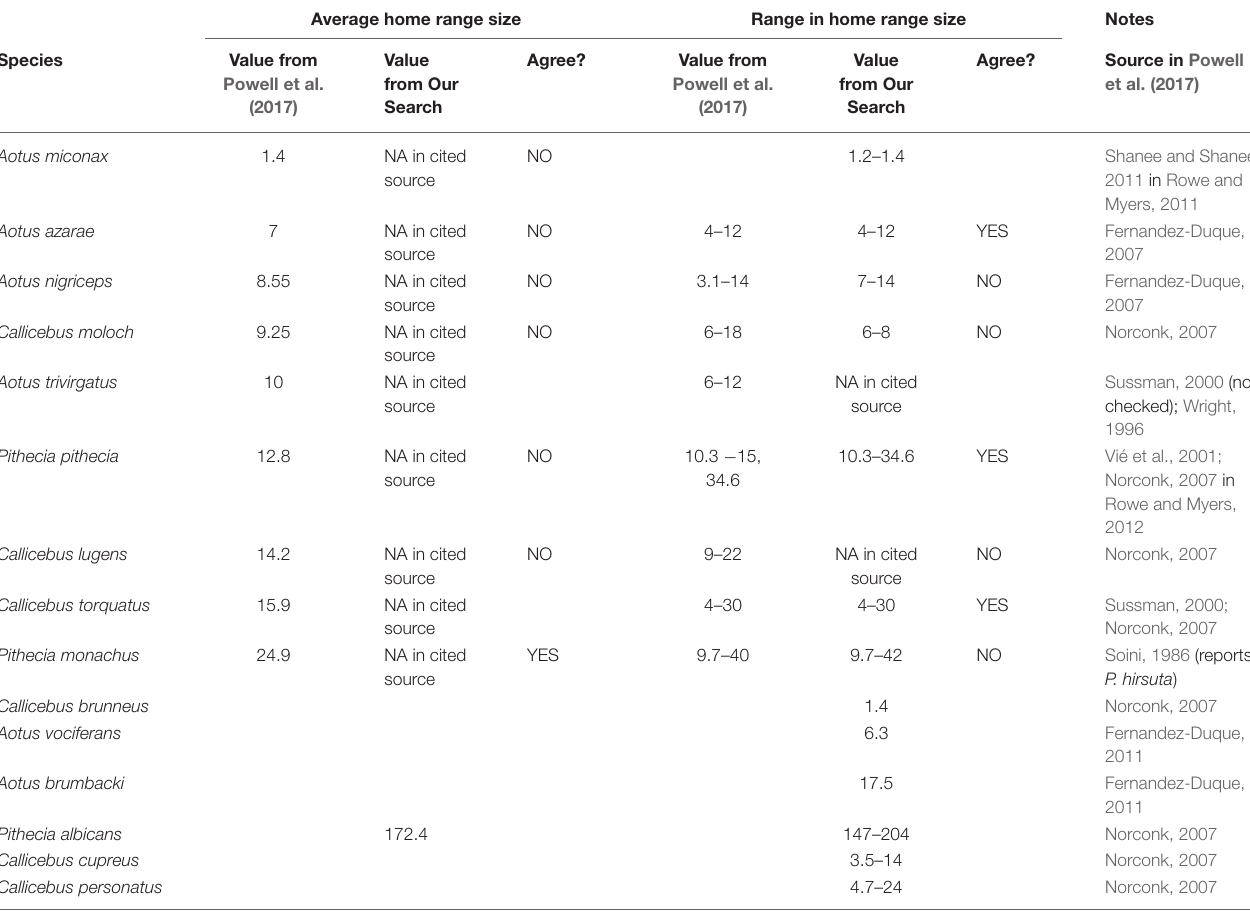
TABLE 3 | Information on average home range size and range of home range sizes for all listed species of the genera Aotus , Callicebus , and Pithecia from Powell et al. (2017) and from our own search of the references cited